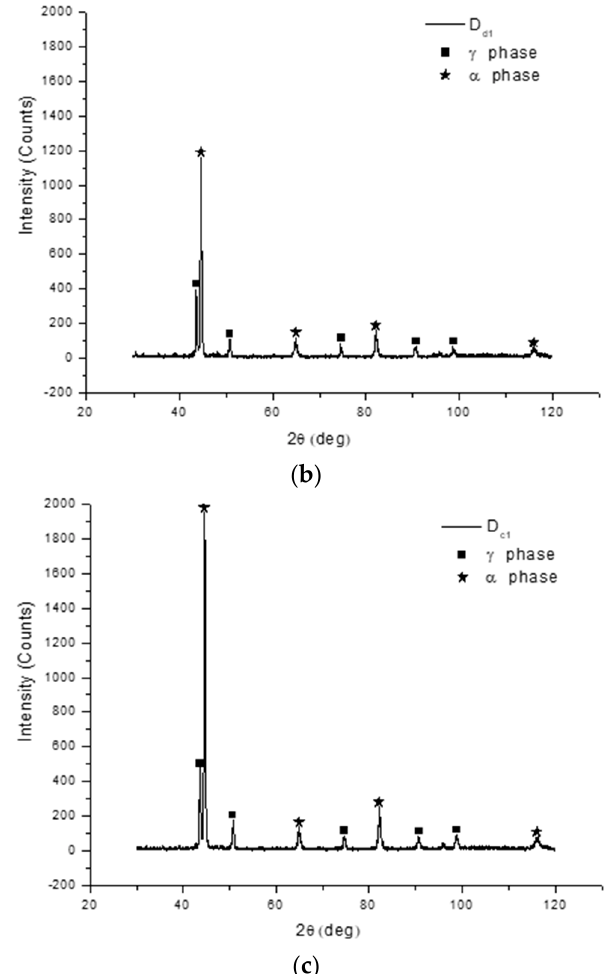
Figure 4. X-ray diffraction (XRD) patterns of the ( a ) D 0 , ( b ) D d , ( c ) and D c specimens.